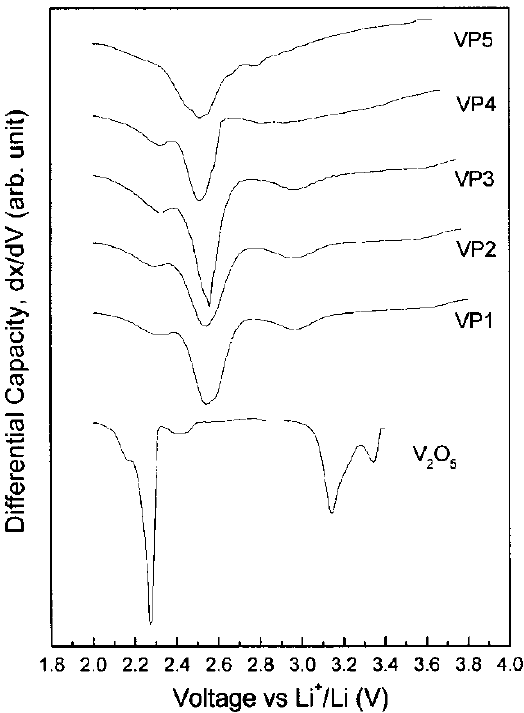
FIGURE 7 The first differential capacity profiles of the first discharges of the pristine V 2 O 5 and